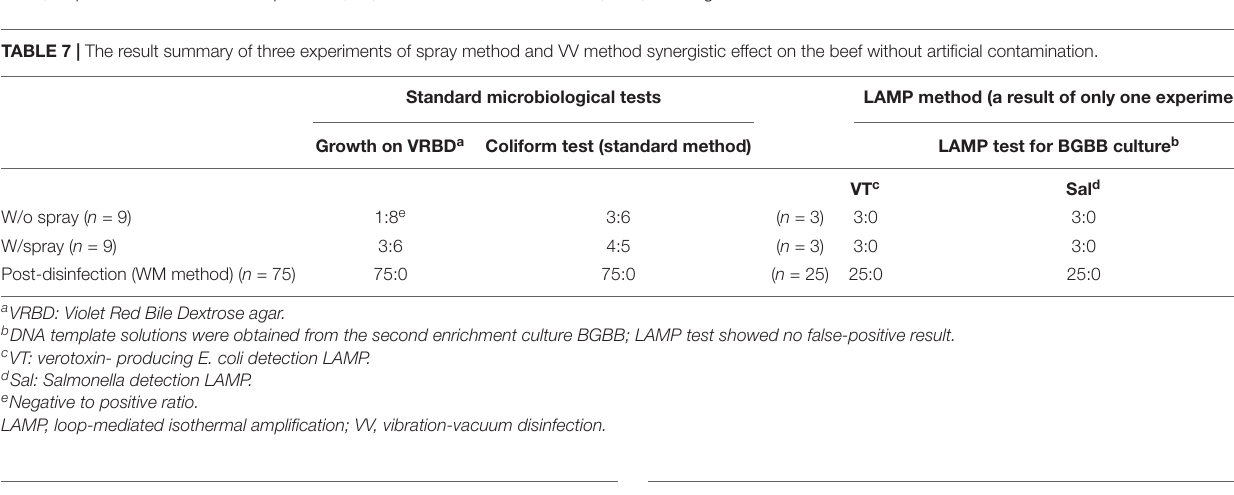
TABLE 9 | A comparison between the WM method and the VV